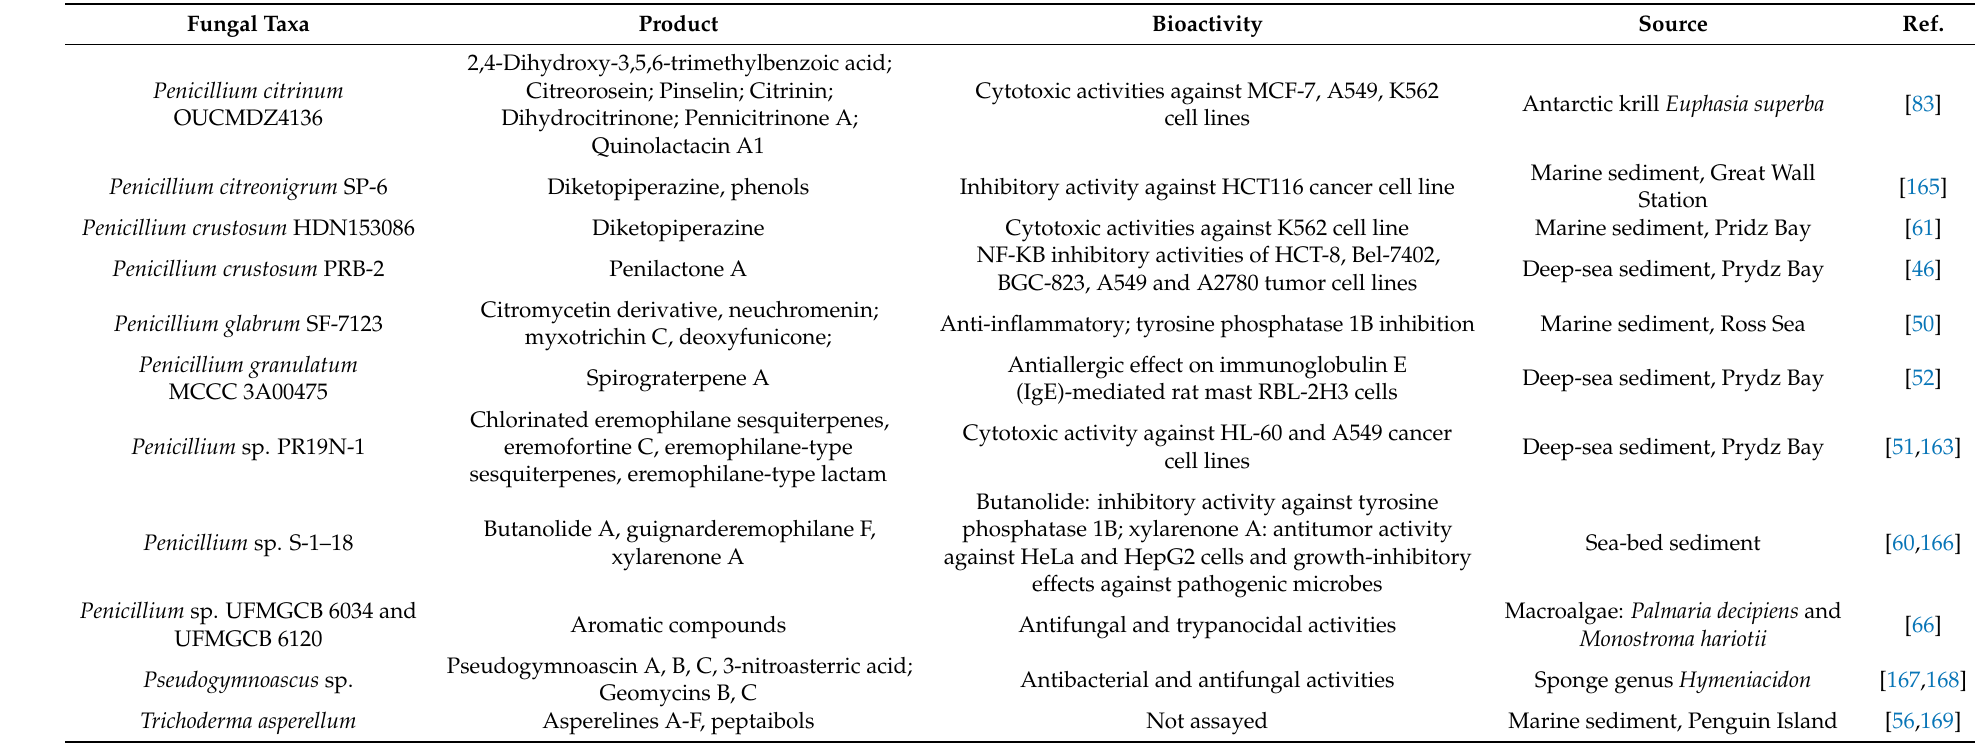
Table 1. Bioactive molecules isolated from Antarctic marine fungi. Available chemical structures of the bioactive compounds have been downloaded from [164] and used to produce Figures S1–S3 for ease of